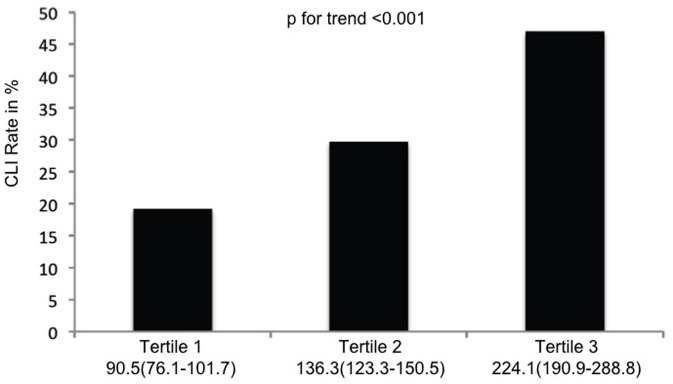
Percentage of patients with CLI stratified by tertiles of PLR. Numbers below the figure are median PLR and the 25th and 75th percentile.